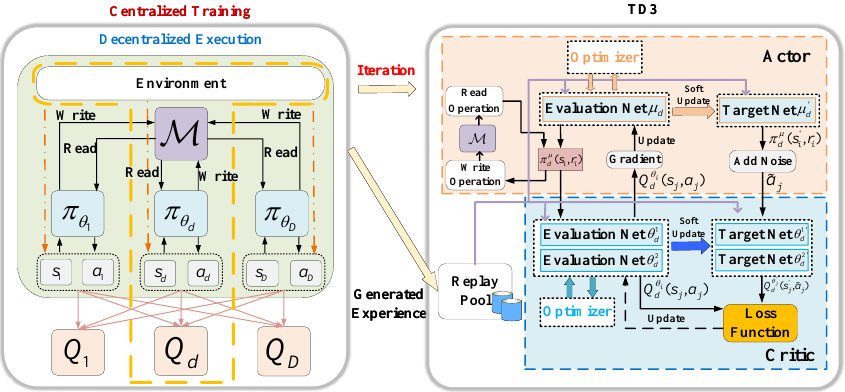
Figure 2. The architecture of the UAFC